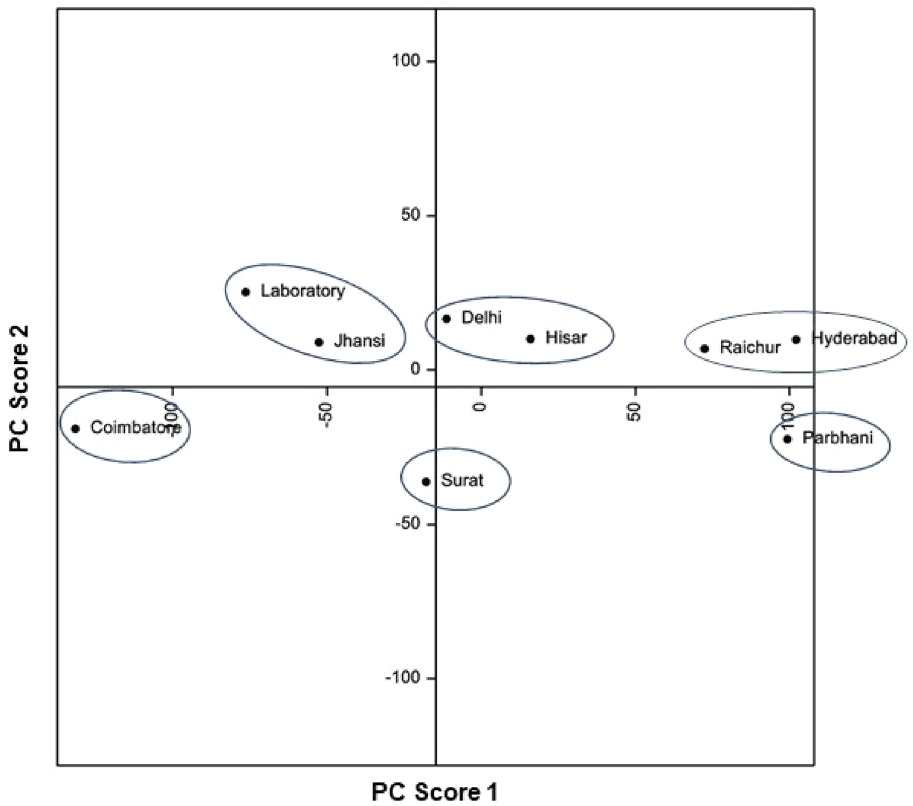
Figure 4. Diversity in different geographical C. partellus populations based on lipophilic compounds, amino acids, biological traits, and damage caused to sorghum and